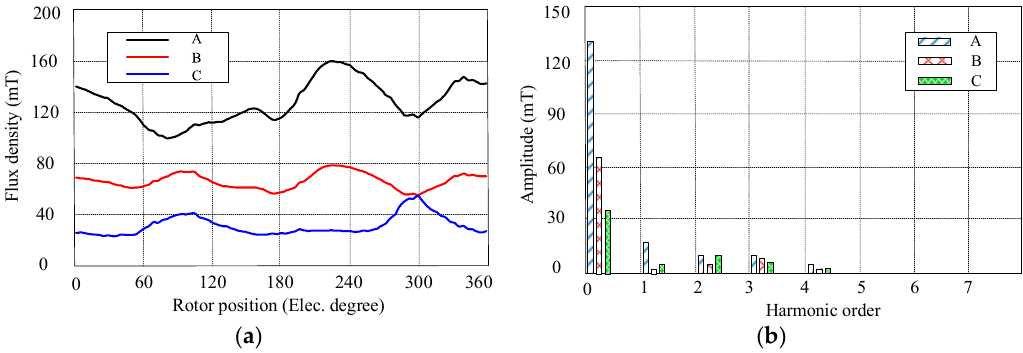
Figure 7. Magnetic flux density of point A, B, and C with rated field-excitation current: ( a ) magnetic flux density and ( b ) harmonic analysis.